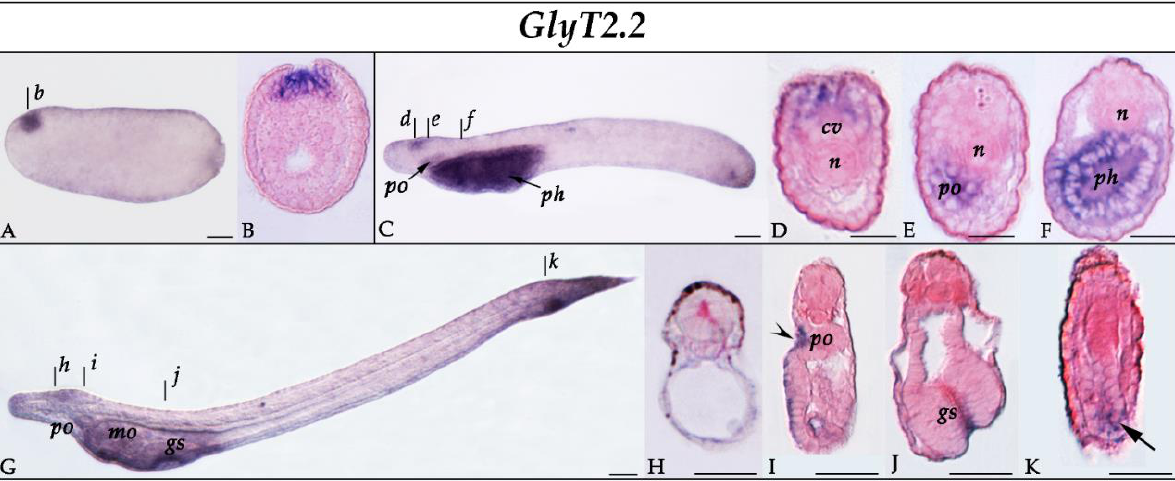
Figure 5. Expression of GlyT2.2 in developing amphioxus. ( A,B ) N1-stage neurula in whole mount ( A ) and cross-section